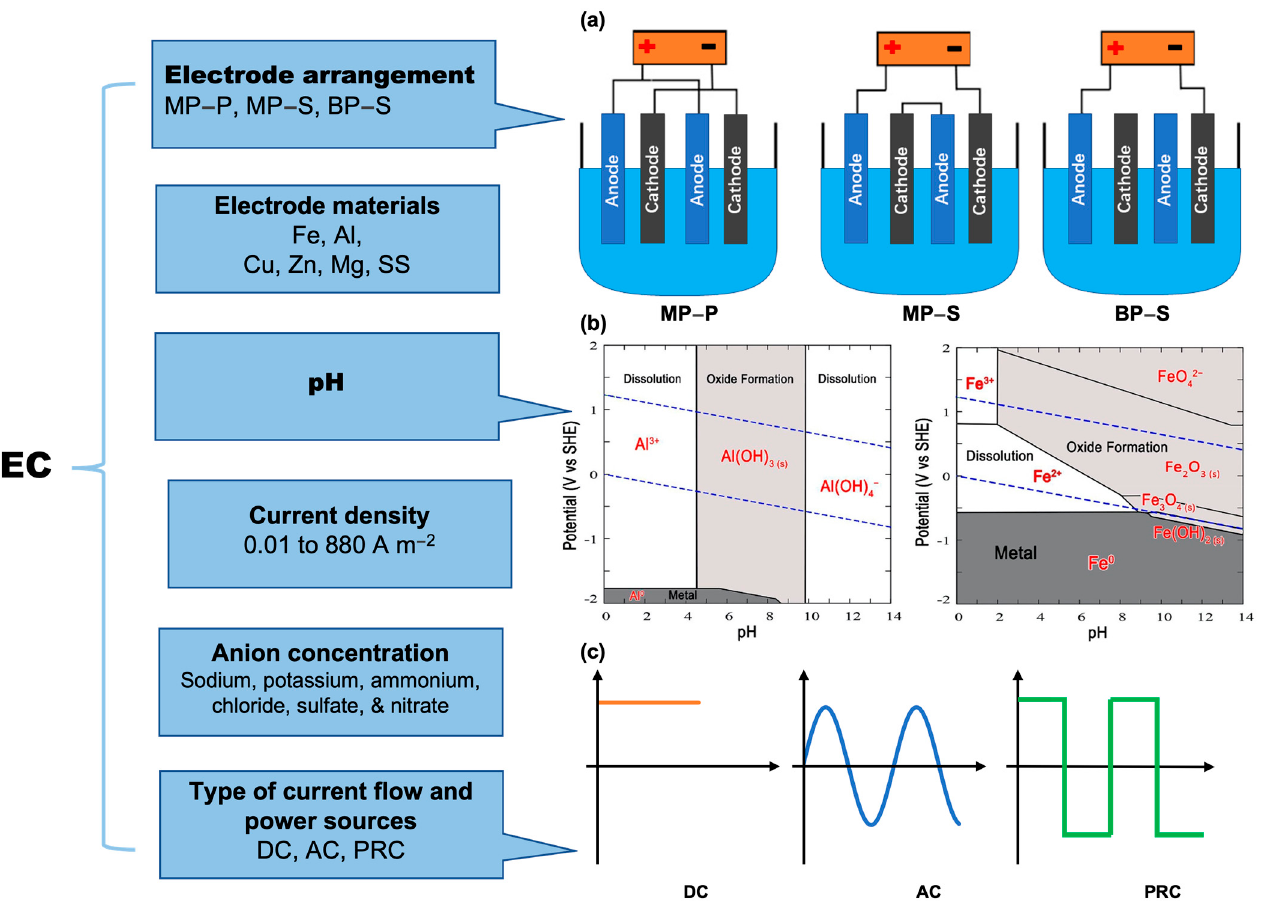
Figure 2. Factors influencing EC’s removal performance ( a ); Electrode arrangement, monopolar par- allel (MP − P), monopolar series (MP − S), and bipolar series (BP − S) [5]; ( b ) EH − pH diagrams at 25 °C of aluminum and iron in water, the dashed lines represent the electrochemical stability range of water [3]; ( c ) Current fl ow type for EC − direct current (DC), alternating pulsed current (AC), polar- ity − reversal current (PRC).